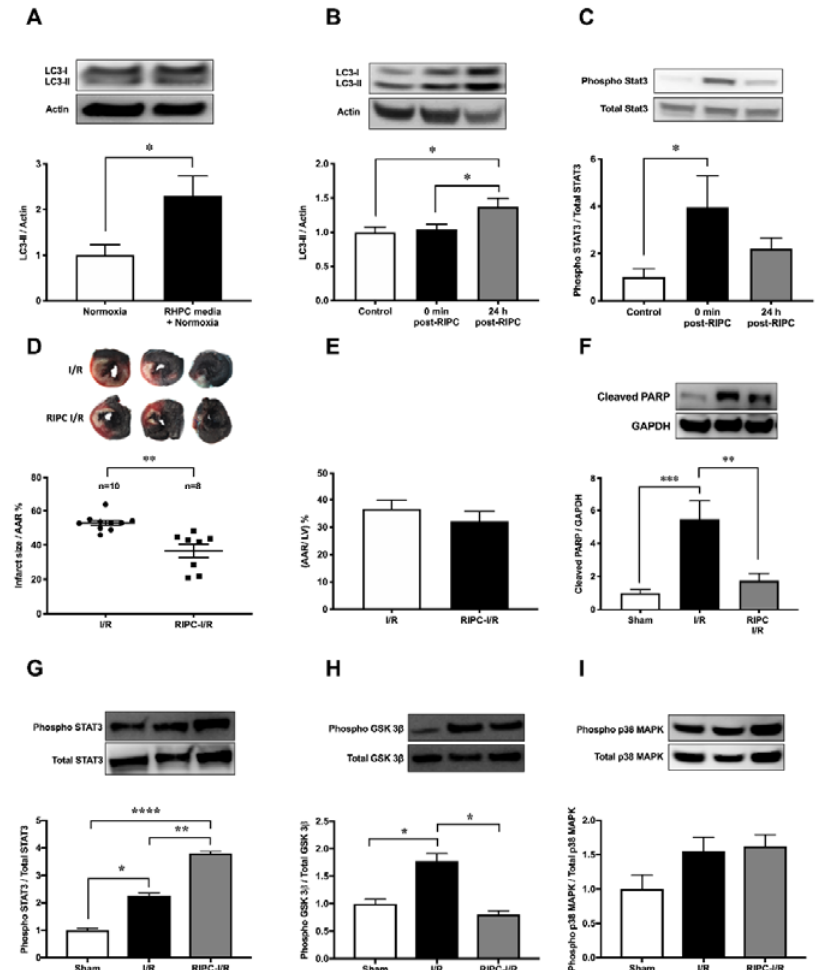
Figure 2. Effect of RIPC on autophagy and the cardioprotective signaling mechanism. Western blot analysis of ( A ) LC3 in H9c2 cells subjected to RHPC (preconditioned) media under normoxic conditions and ( B ) LC3 in the rat heart and ( C ) STAT3 phosphorylation in the rat heart assessed in the control group (without any intervention or sham surgery), at 0 min and 24 h post-RIPC. ( D – I ) Rats subjected to I / R with and without prior RIPC. ( D ) MI size expressed as the percentage of infarct size / AAR, ( E ) cumulative data of AAR / LV expressed as the percentage of the mean ± SEM. Western blot analysis of rat heart tissue assessing the ( F ) cleaved PARP ( n = 8), ( G ) phosphorylated STAT3 ( n = 8), ( H ) phosphorylated GSK-3 β ( n = 8), and ( I ) phosphorylated p38 MAPK ( n = 8) levels at 24 h post-I / R with and without prior hindlimb RIPC. Results are expressed as mean ± SEM relative to control; * p < 0.05, ** p < 0.01, *** p < 0.001, **** p < 0.0001.